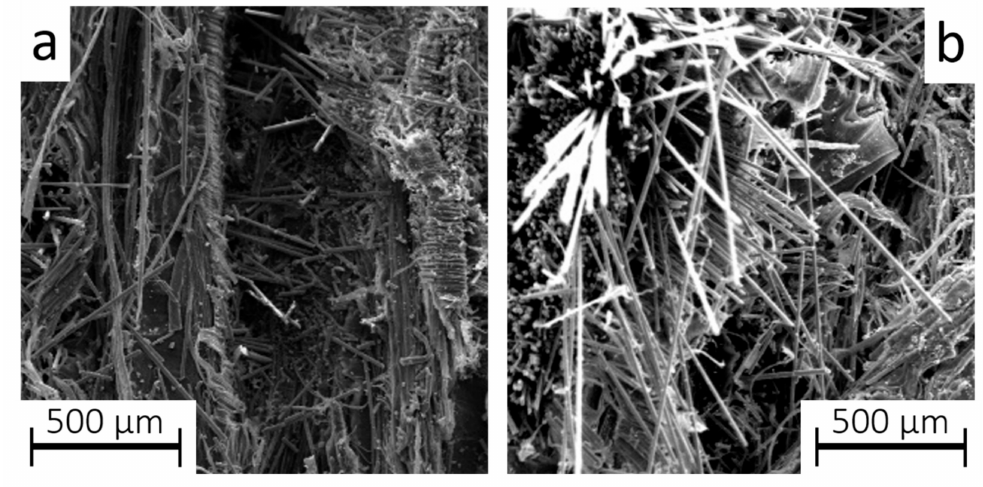
Figure 5. SEM micrographs of ( a ) PA11 TL and ( b ) PA11 P40 TL based composites.